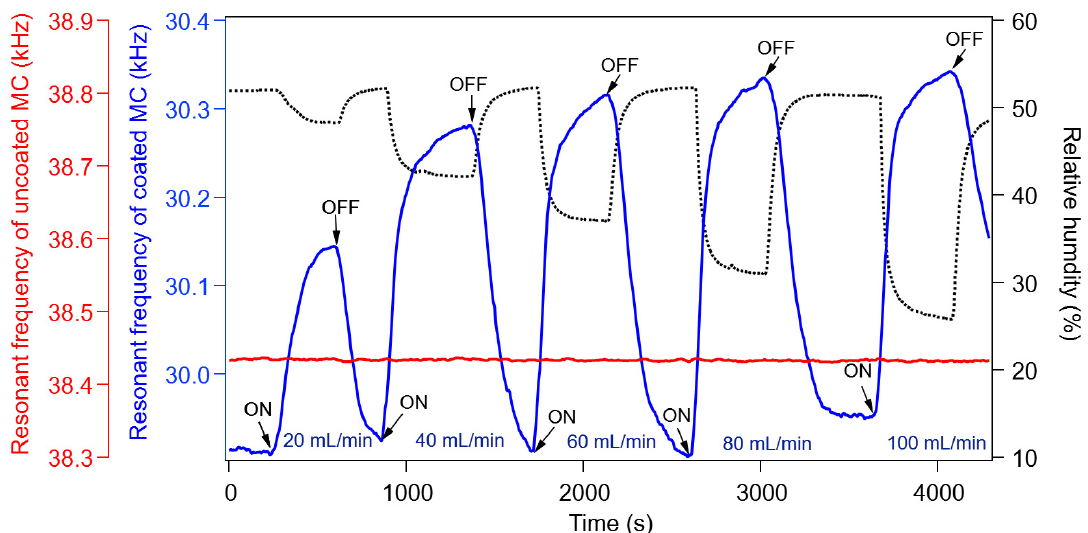
Figure 5. Response characteristics of Al-doped ZnO nanorod-coated MC showing an increase of resonant frequency (blue solid line) and a decrease in RH (black dotted line) due to CO exposure. The increase of resonant frequency and, at same time, the decrease of RH, were also observed with increasing the gas flow rate from 20 mL / min to 100 mL / min. For the uncoated MC (red solid line), there was no response to gas exposure.